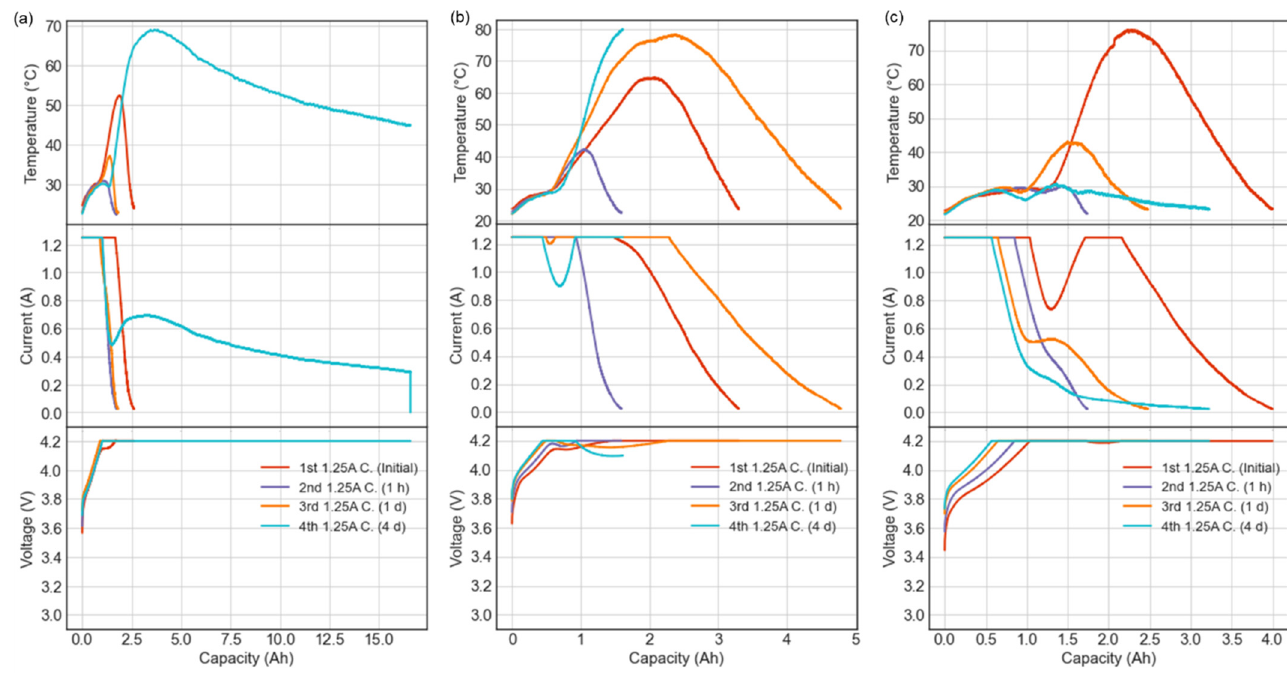
Figure 4. Example electrical measurement results of 3 different recycled cells (panels ( a – c ), respec- tively) in 1.25 A cycles between 3.0 and 4.2 V, with 1-h rest between the 1st and 2nd cycle, 1-day rest between the 2nd and 3rd cycle, and 4-day rest between the 3rd and 4th cycle. In the legends, “C.”, “D.”, and ‘R.’ represent charge, discharge, and rest processes, respectively.